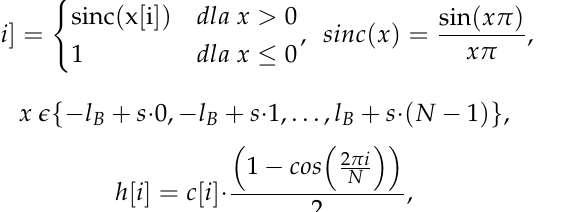
where N is the number of FIR filter coefficients, x is the vector of discrete argument values for which the FIR filter coefficients are calculated, s is the discrete shift value between the sample x [ i ] and x [ i + 1 ] , c is the vector of coefficients calculated according to the sinc ( x ) relationship, h is the vector of coefficients using the relationship for the Hann window, i is the successive index of the FIR filter coefficient and i ∈ ( 0, N − 1 ) , l B means the cut-off value of the FIR filter corresponding to the upper and lower cut-off frequency. The block diagram of simulation and recognition radar signals is presented in Figure